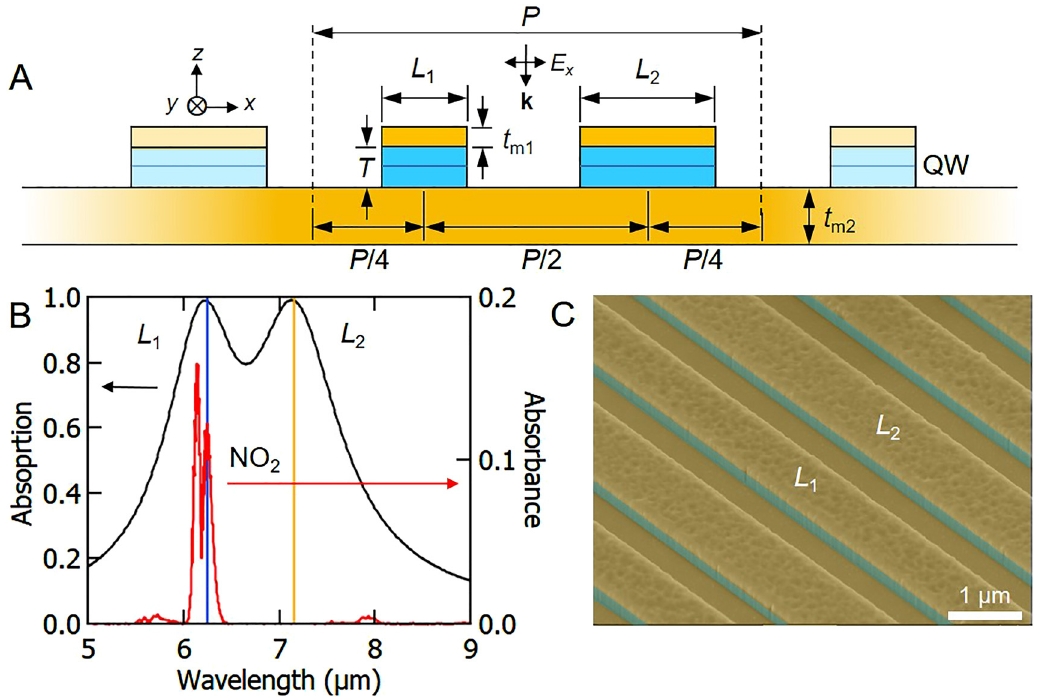
Figure 1: Design and fabrication of dual-band metasurface quantum well infrared photodetectors (QWIPs). A) Cross section showing critical dimensions of individual QWIP stripes. E x and k indicate the electric fi eld and wave vector of incident light. Quantum well (QW) position is indicated by lines in the semiconductor (blue) layer. B) Simulated spectra showing absorptionpeaks of QWIP stripes with L 1 and L 2 and target wavelengths 6.25 μ m (blue) and 7.15 μ m (orange). The red curve is NO 2 absorbance at 100 ppm-m in 1 atm N 2 at 25 ° C (right axis). C) Colorized SEM image of QWIP stripes in a dual-band device. Gold indicates the Au substrate and top stripe. Blue indicates the QWIP